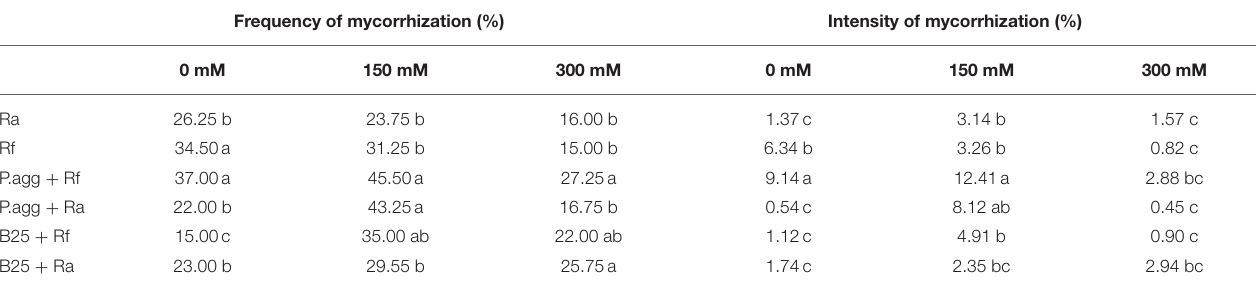
TABLE 4 | Effects of the co-inoculation of PGPR and AMF on the frequency and intensity of mycorrhization of C. obesa plants under salt stress. Frequency of mycorrhization (%) Intensity of mycorrhization